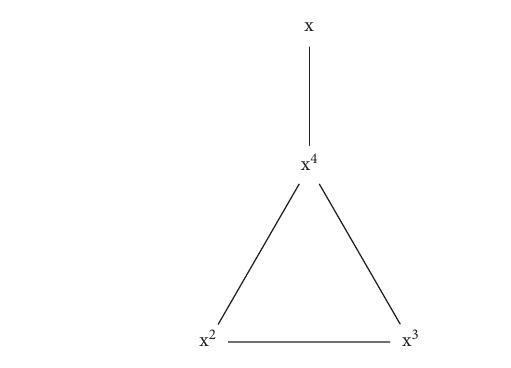
Figure 2: S 4 M monogenic semigroup graph (corresponding hydrogen-suppressed molecular